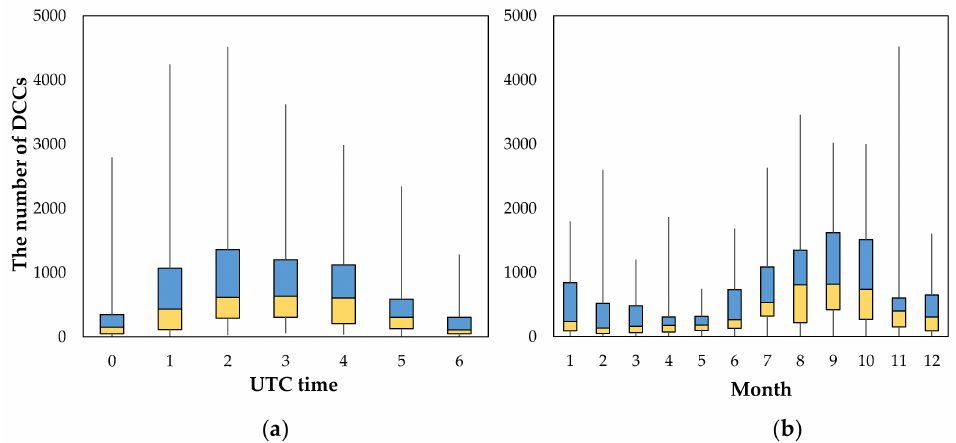
Figure 2. ( a ) Hourly and ( b ) monthly distribution of the number of DCCs observed in a single scene over the GEMS observation area corresponding to the GEMS FOV from AHI data taken at three-day intervals for the period July 2016–June 2017. The yellow and blue boxes represent the lower and upper quartile to the median,